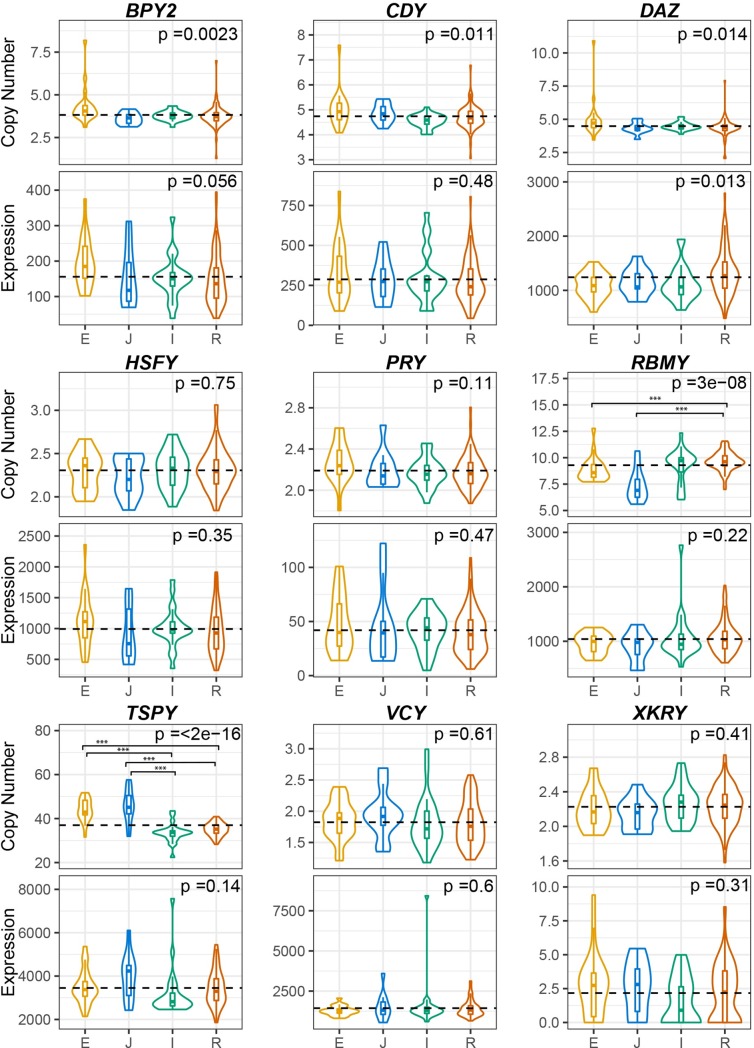
The distribution of ampliconic gene copy numbers and expression levels across Y haplogroups.For each plot the x-axis shows Y haplogroups: E—African (N = 22, yellow), I—European (N = 24, green), J—Western Asian (N = 11, blue), and R—European (N = 85,red), and the y-axis shows copy number estimates or gene expression levels. The black dashed line represents the overall mean copy number or expression values for all the samples on each plot. The permutation-based significance of pairwise haplogroup comparisons is shown with stars (*** < 0.001, ** < 0.01, * < 0.05 P-value). The one-way ANOVA test P-values are printed at the top of each plot. Bonferroni-corrected cutoff for nine tests (0.05/9 ≈ 0.006) is used to identify significance of ANOVA.